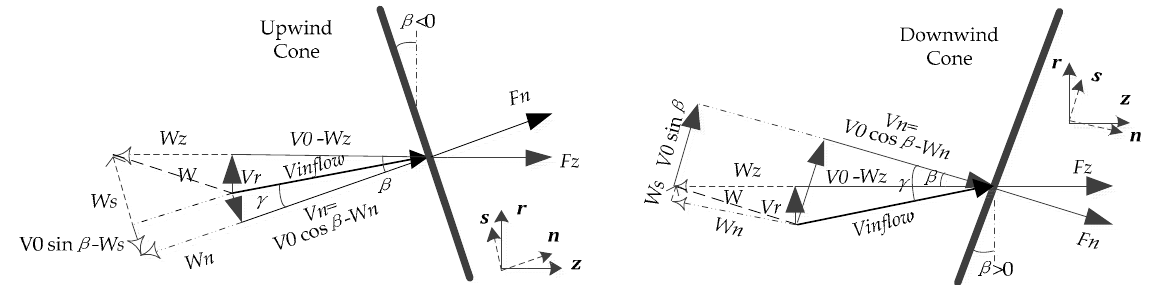
Figure 6. Inflow velocity decomposition for an upwind and a downwind coned rotor. Due to the presence of Vr , the resultant velocity Vinflow in the YZ plane was not horizontal and did not equal to V 0 - Wz , as shown in Figure 6. The velocity decomposition was different for the upwind and downwind coned configurations. For an upwind